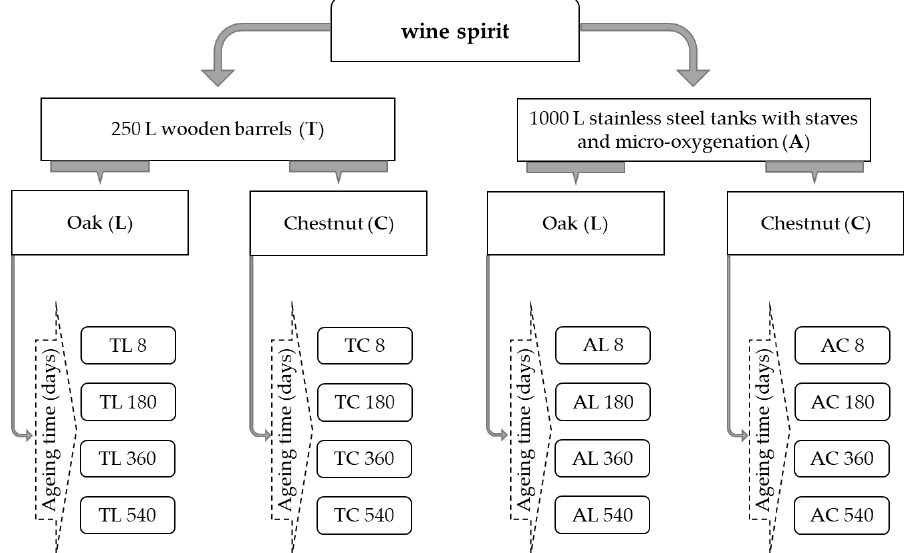
Figure 1. Scheme of the assay representing the different experimental units according to the ageing technology, the wood used and the ageing time; three replicates were used for each barrel modality and two replicates were used for each stainless steel tank with micro-oxygenation modality.